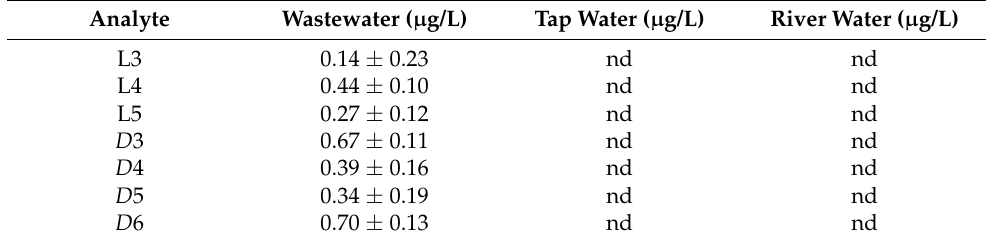
Table 5. VMSs concentrations in real samples ± Global